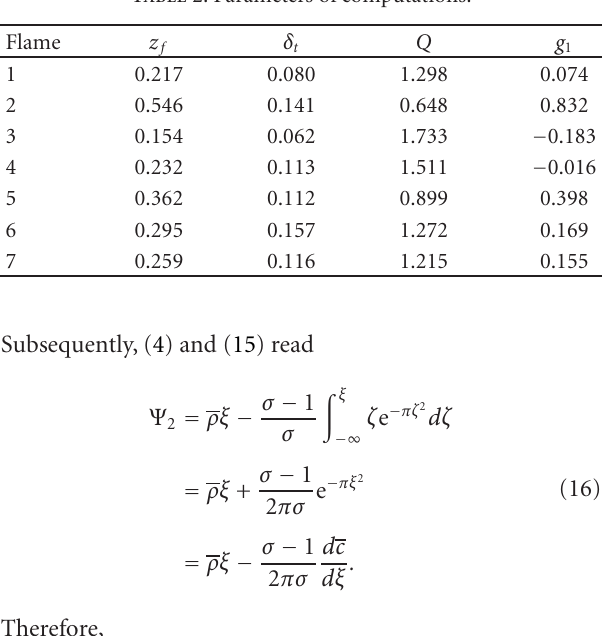
Table 2: Parameters of